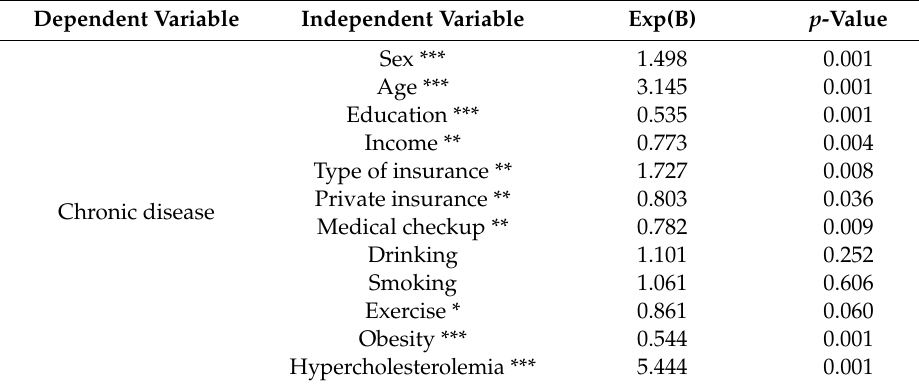
Table 5. Factors a ff ecting the development of chronic